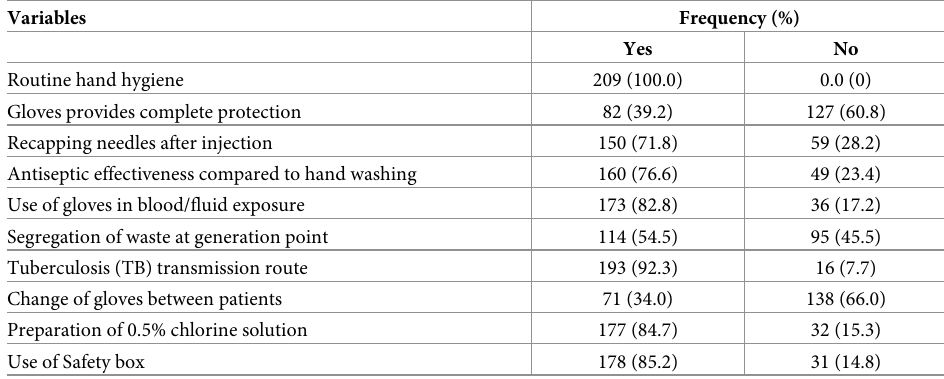
Table 3. Knowledge of respondents on IPC guideline (n =